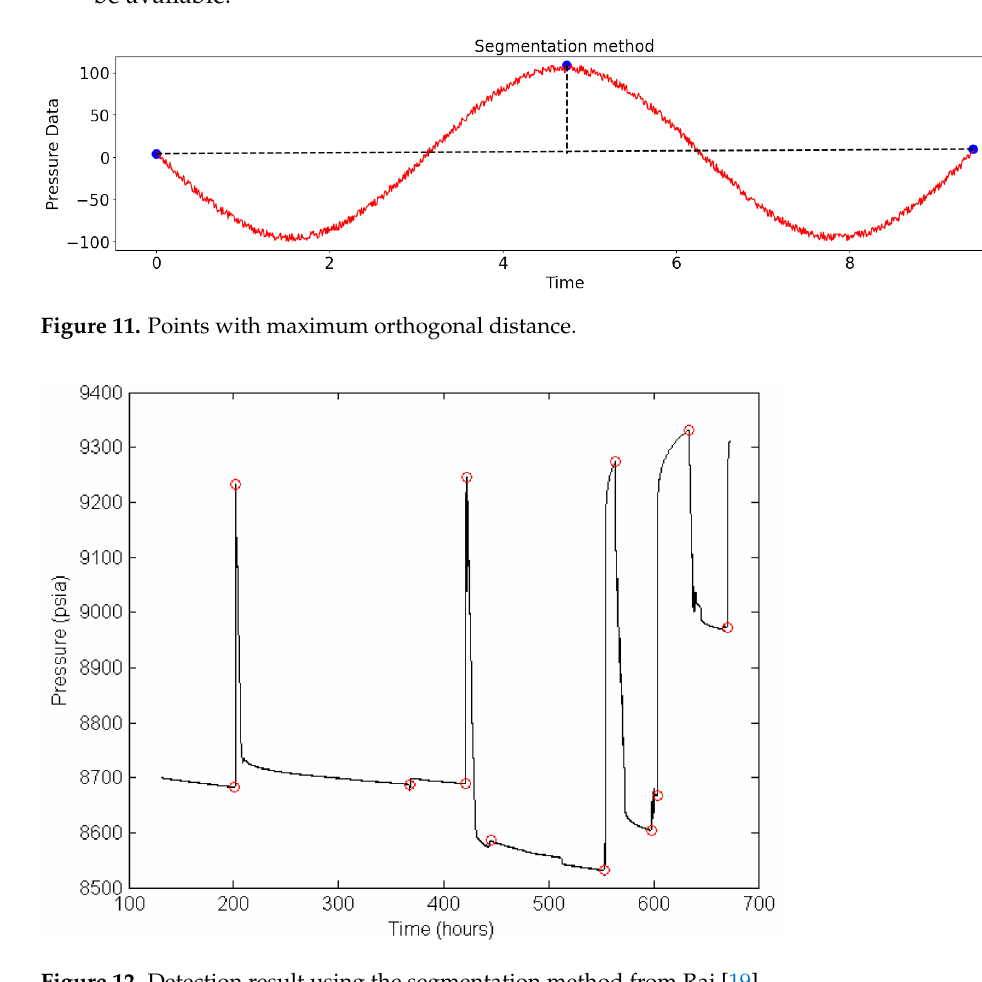
Figure 12. Detection result using the segmentation method from Rai